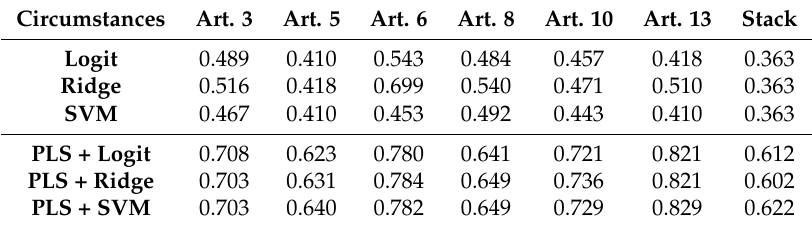
Table 6. Accuracy with tf-idf input on circumstances.